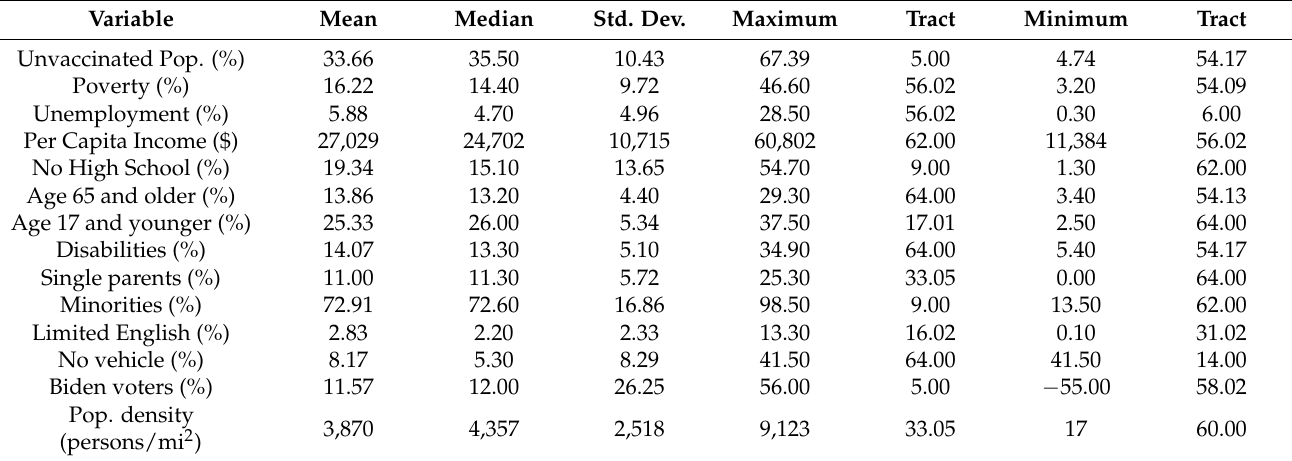
Table 1. Summary statistics for variables by census